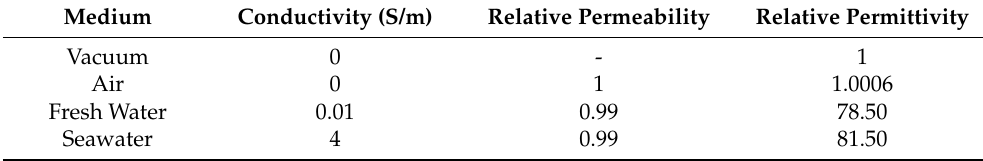
Table 7. EM parameters comparison of different